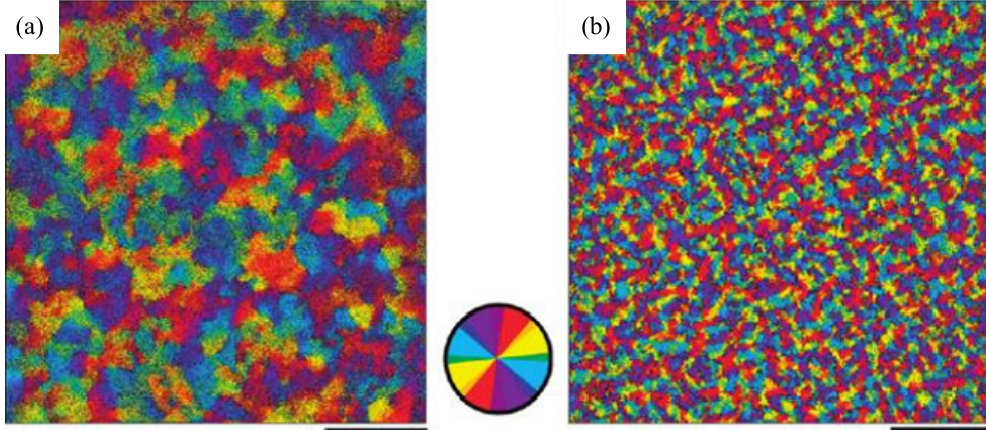
Figure 10. Orientation maps of ( a ) DPPT-TT and ( b ) DPPT-2T obtained according to dark-field TEM images, which indicate the domain size with scale bars representing 2 μ m, (Adapted with permission from [37]. Copyright 2011 American Chemical Society).